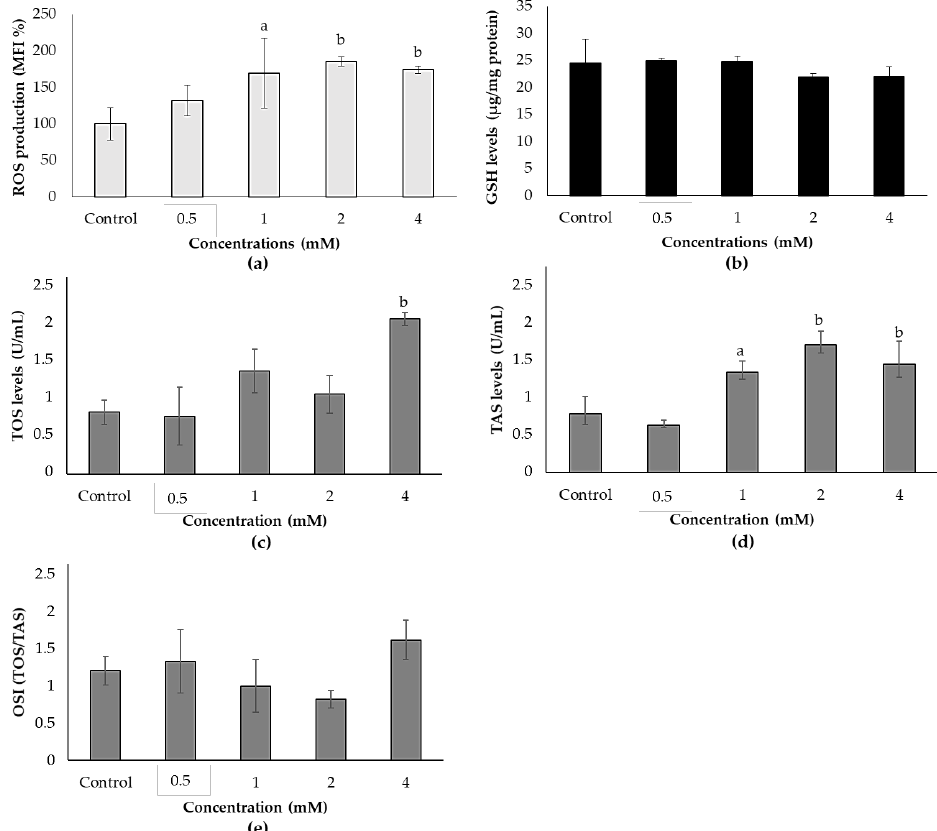
Figure 2. Effects of ACE on ( a ) ROS production; ( b ) GSH levels; ( c ) TOS levels, ( d ) TAS levels and ( e ) OSI in SH-SY5Y cells after 24 h of treatment. Data are presented as mean ± SD; and statistically significant changes are indicated as a: p < 0.05 and b: p < 0.01.